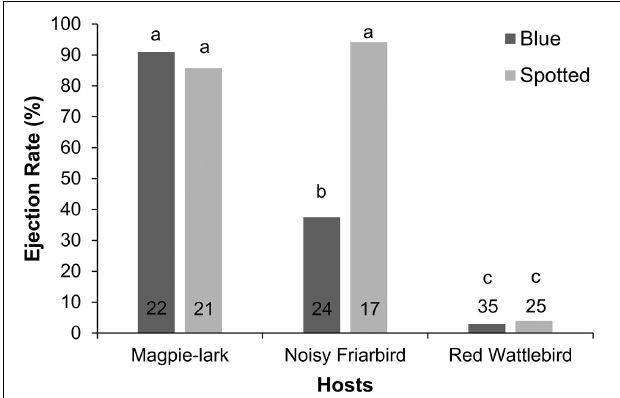
FIGURE 4 | Ejection rates of three Pacific Koel hosts for two model egg treatments from 2013 to 2016 in Canberra, ACT and Western Sydney, NSW combined. Number of nests tested for each treatment are at the bottom of each column and letters indicate significant differences (GLM, Tukey HSD, P <